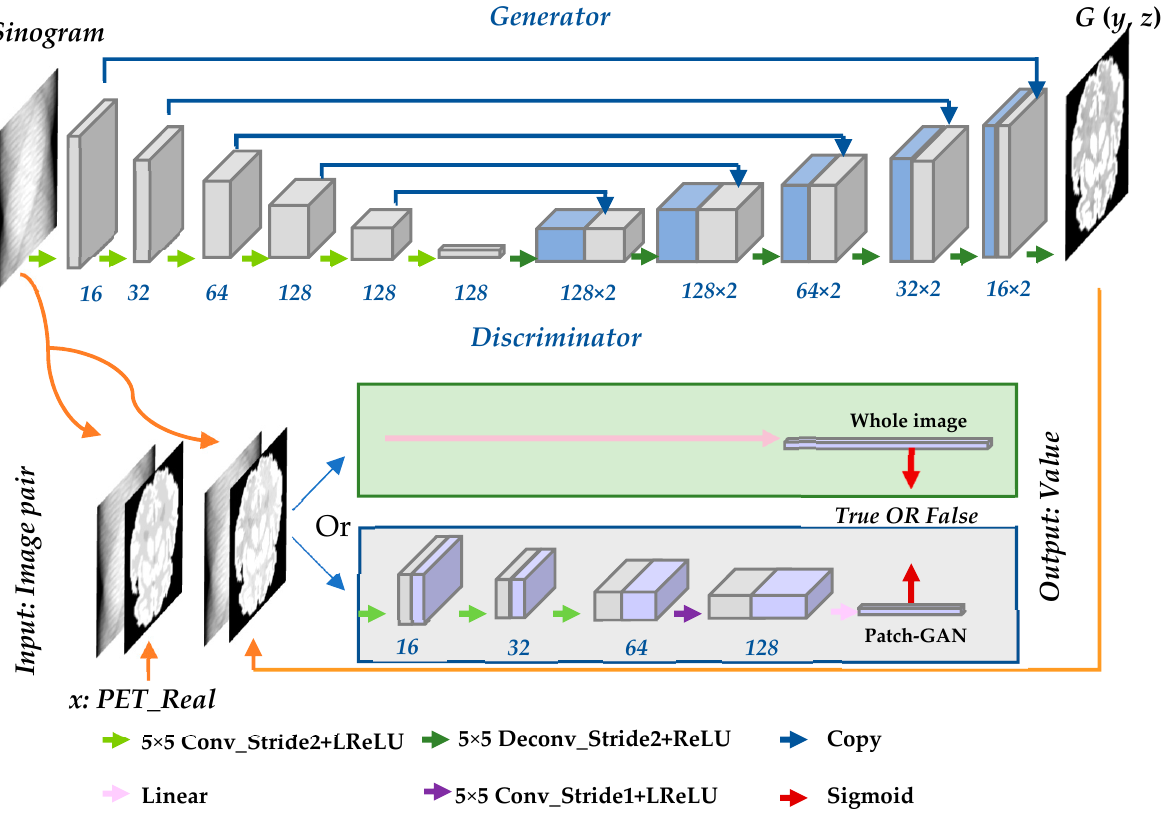
Figure 1. Training framework of the direct reconstruction process.